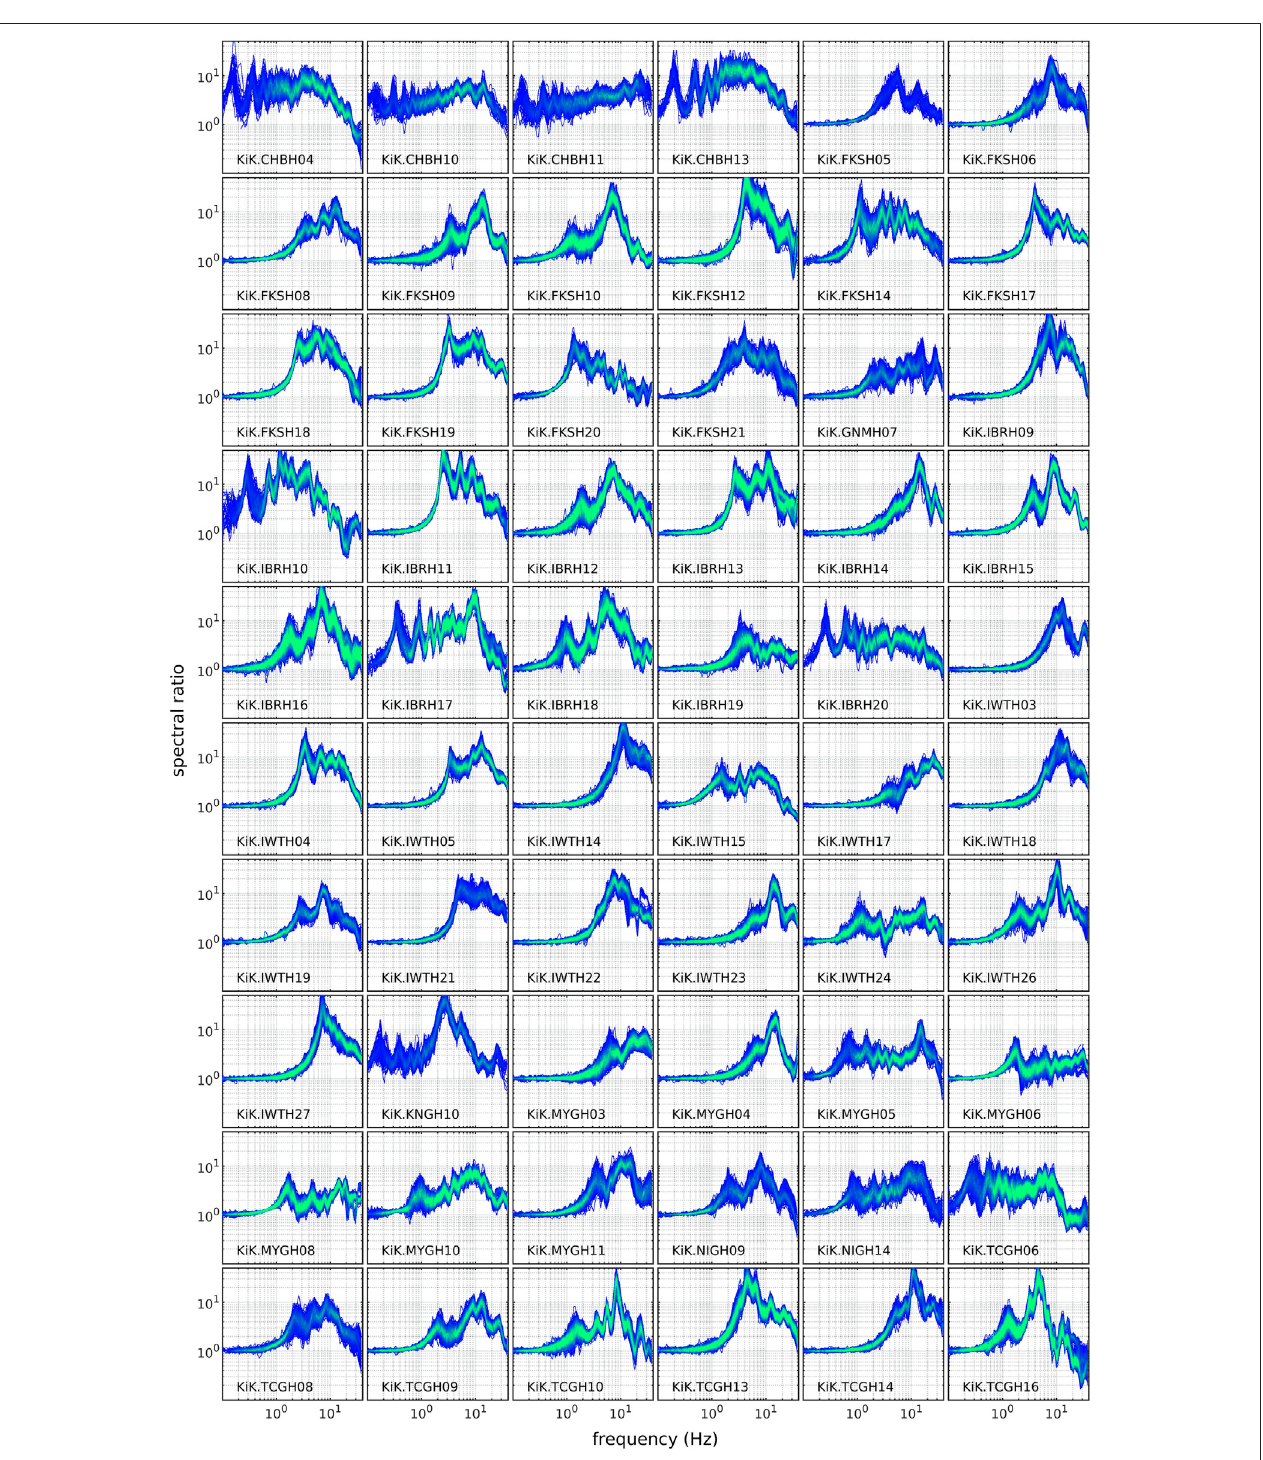
FIGURE 2 | Ampli fi cation function computed from the SBSR between 60 pairs of stations in Japan. The color from dark blue to light green indicates an increasing density of curves, each curve corresponding to one single earthquake.